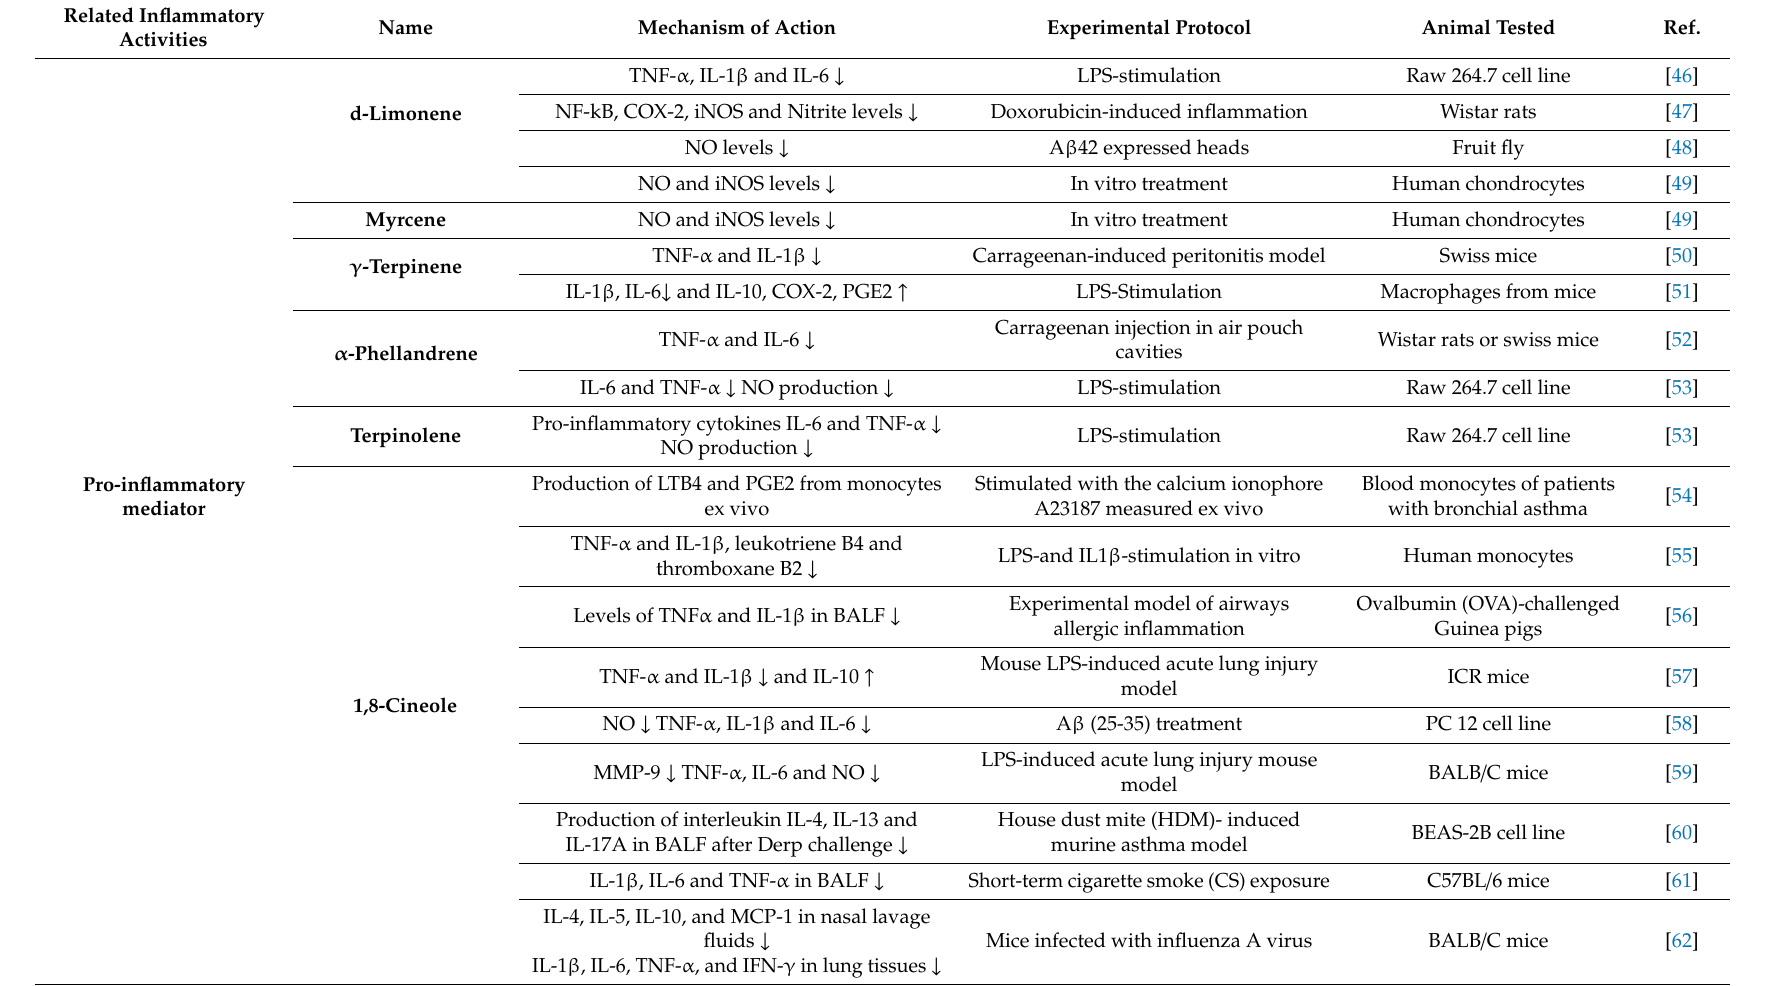
Table 2. The anti-inflammatory activities of the major 23 terpenes and terpenoids emitted in the forests and their action mechanisms. Related Inflammatory